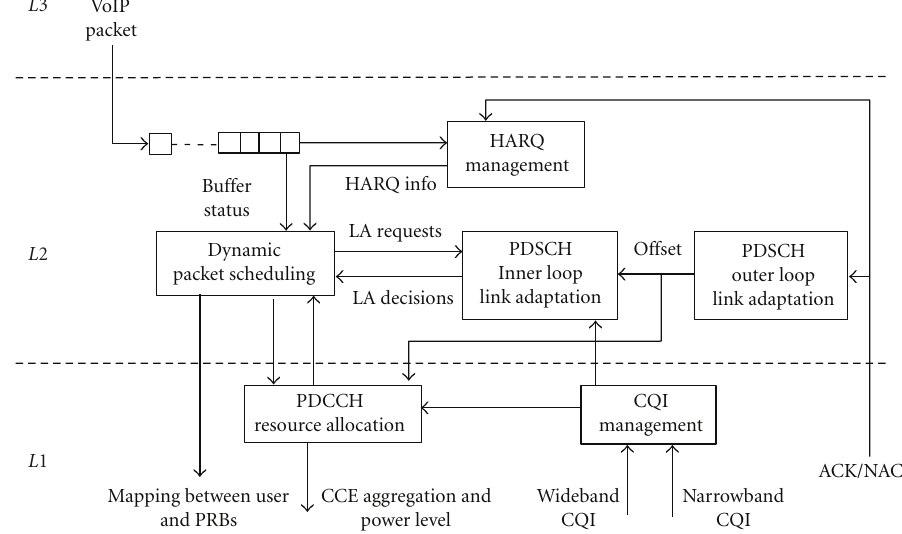
Figure 2: Main RRM functionalities and their interactions in